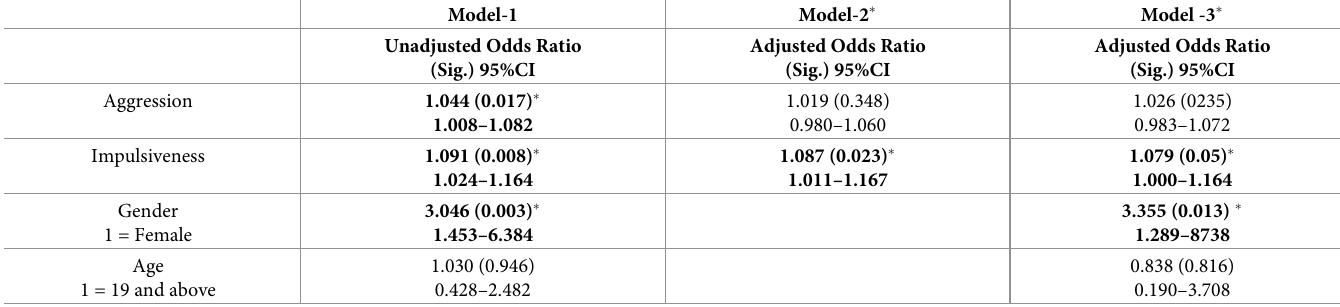
Table 5. Association between gender, age, personality factors with suicide attempt among Idu Mishmi (Multivariate logistic regression